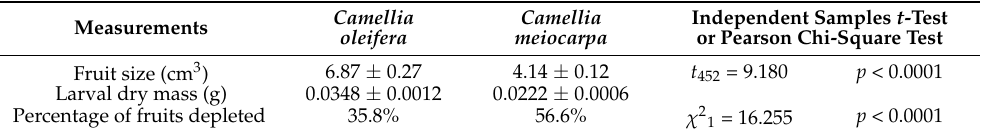
Table 2. Comparisons of measurements performed on infested fruits between the two Camellia species. The mean is presented as the mean ± SE .